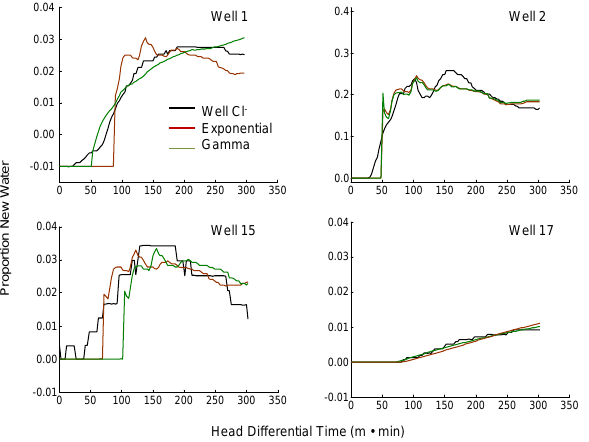
Fig. 9. Optimized models of chloride truncated at the end of head differential time for salt-added test. Well 2 is displayed on a larger- scale axis because of larger-scale response.